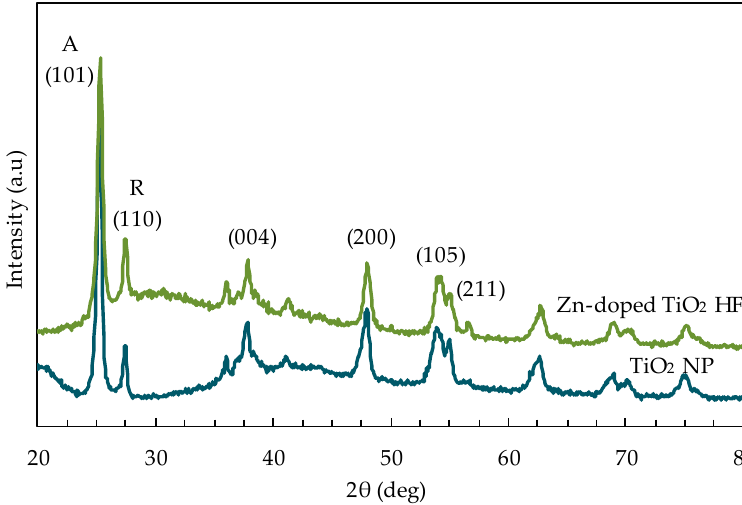
Figure 1. XRD pattern of TiO 2 NP and Zn-doped TiO 2 HF.